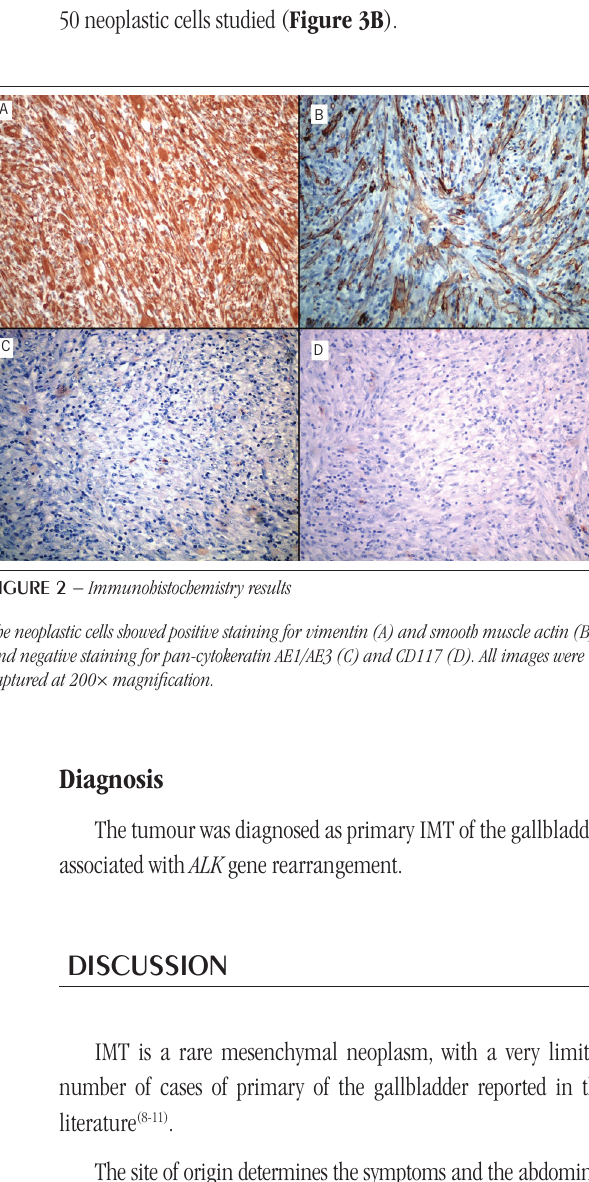
surface appearance, with variable hemorrhage, calcification or necrosis; it can measure between 1 cm and 20 cm (1, 6) .